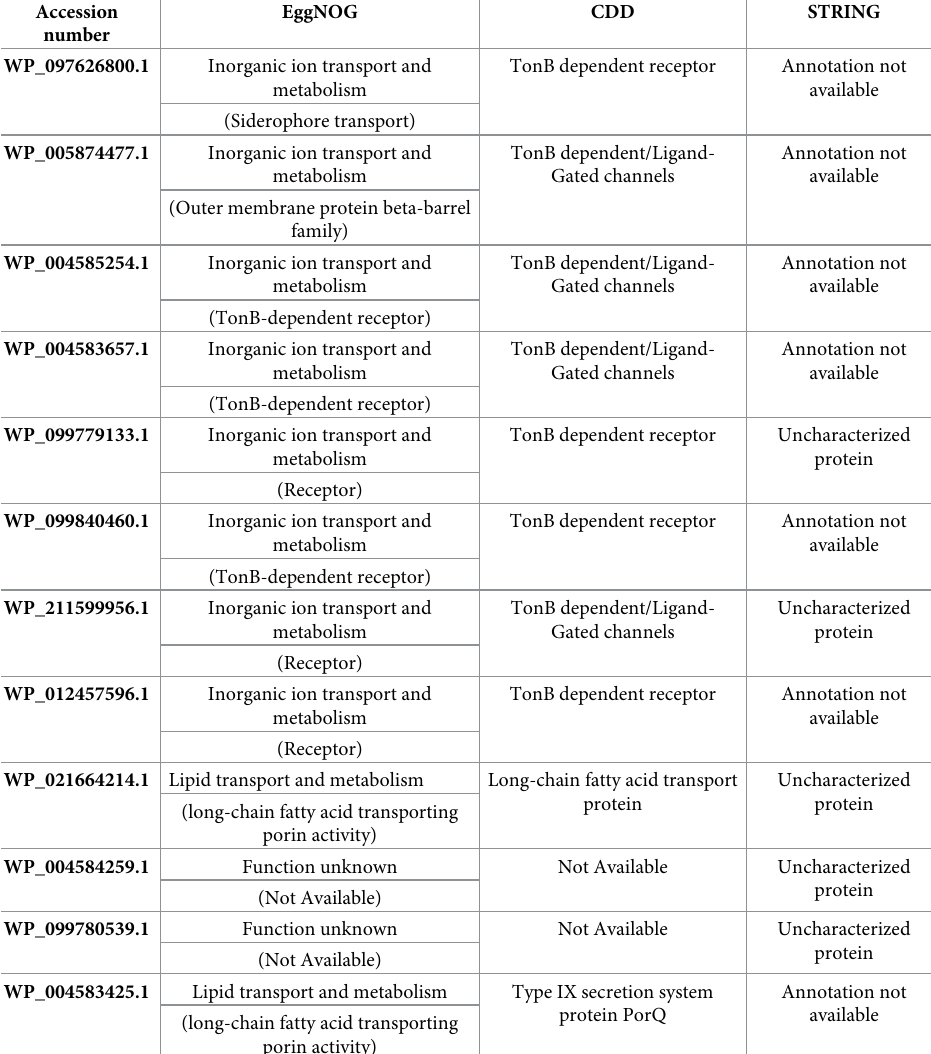
Table 2. Data on conserved domains of putative immunogenic proteins against P . gingivalis using NCBI Con- served Domain Database, EggNOG and STRING